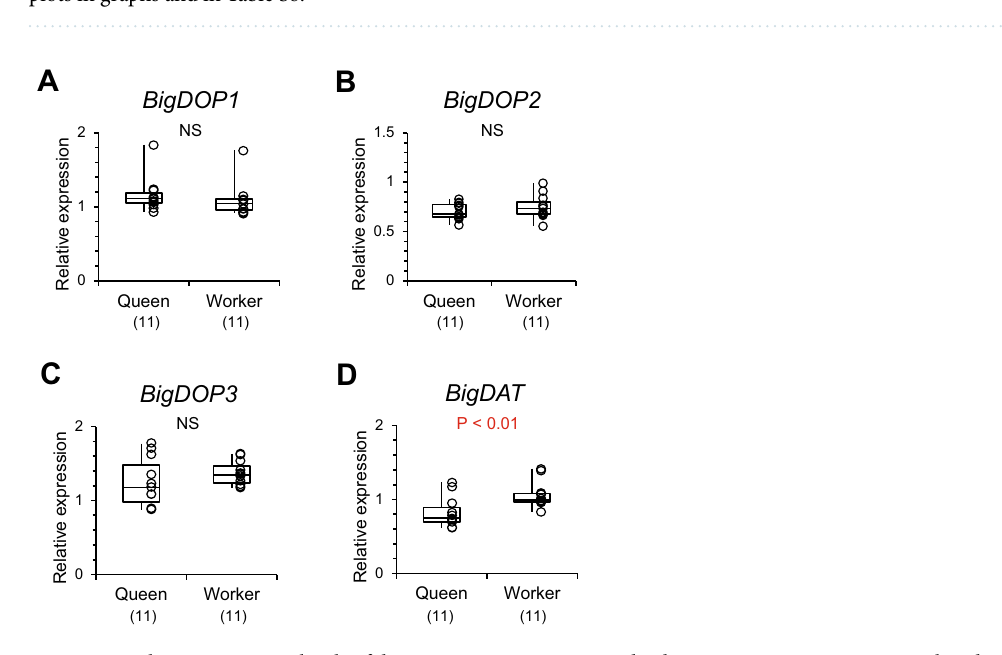
Figure 5. Relative expression levels of enzyme genes involved in the metabolism of dopamine, tyramine, and octopamine were analyzed by qPCR. ( A ) Bombus ignitus tyrosine hydroxylase gene ( BigTH ), ( B , C ) B. ignitus DOPA decarboxylase ( BigDDC -a and BigDDC -b), ( D ) B. ignitus N -acetyltransferase ( BigNAT ), ( E ) B. ignitus tyrosine decarboxylase ( BigTDC ), F: B. ignitus tyramine-β-hydroxylase ( BigTBH ). Numbers in parentheses indicate the number of samples examined. Individual data of relative gene expression levels were indicated by plots in graphs and in Table S8.